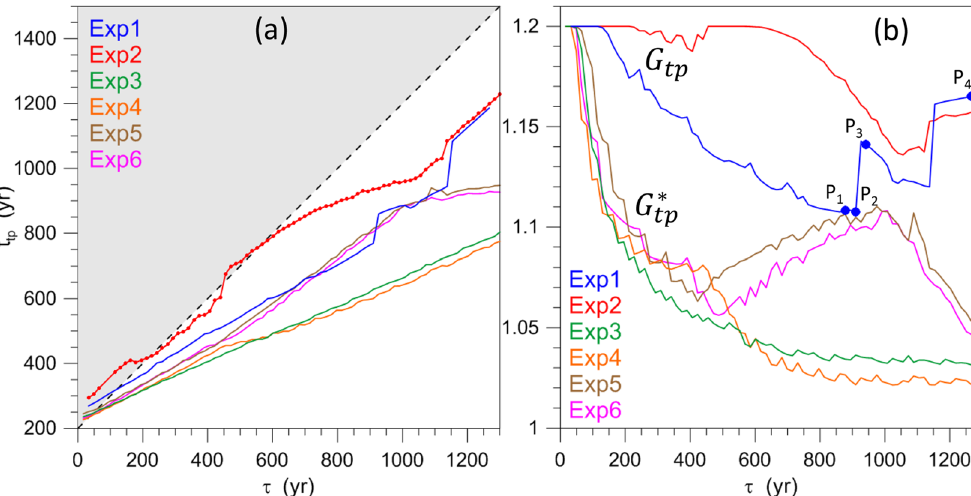
Figure 5. Dependence of key results on the ramp duration τ in experiments Exp1–Exp6. ( a ) TP timing t tp versus τ ; when a line portion lies in the grey area the tipping occurs after the end of the ramp. The filled circles on the red line indicate the presence of data; their absence indicates that no TP is reached. ( b ) Forcing values G ( t G ∗ τ ; the filled blue circles P 1 − P 3 correspond tp ) at the TP (for Exp1 and Exp2) or tp (for Exp3–Exp6) versus to the ESs for Exp1 shown in Supplementary Figure S5, while the filled circle P 4 corresponds to the orange ES of Supplementary Figure S6.